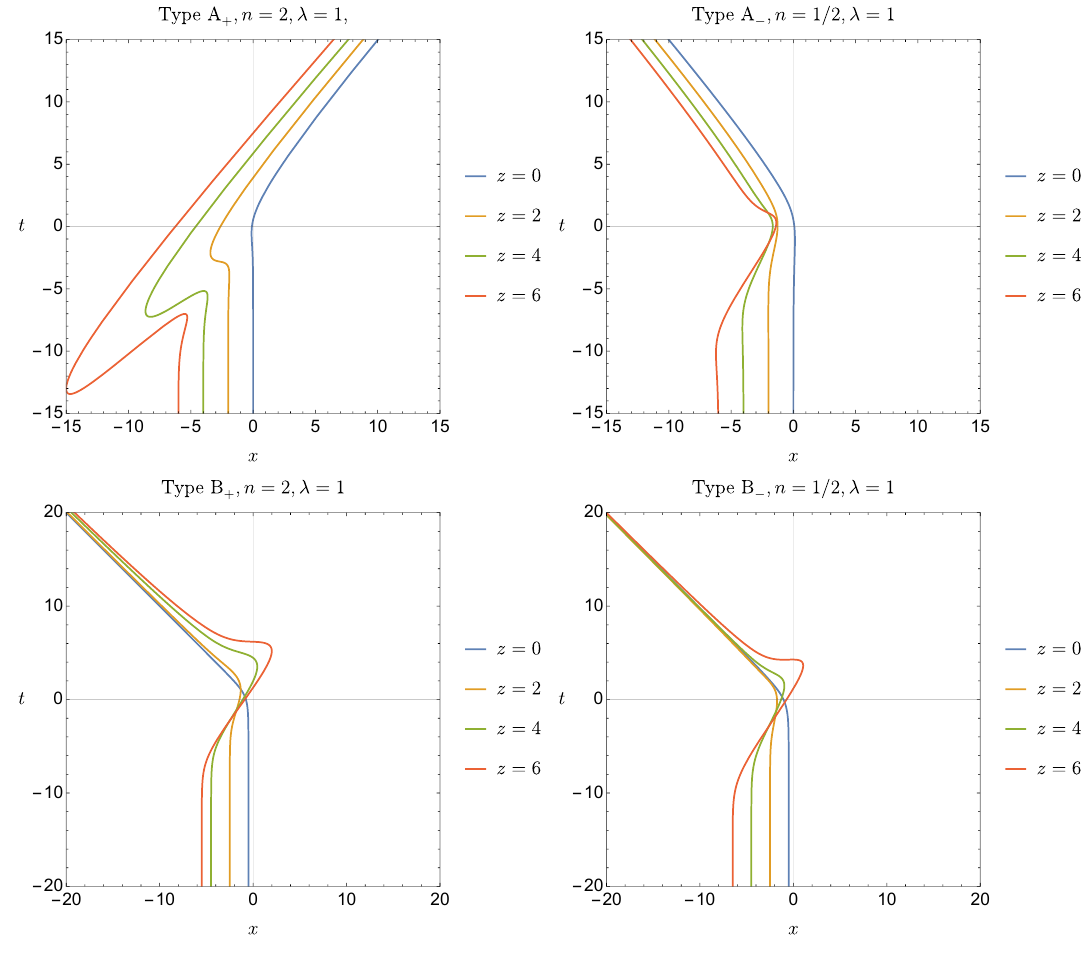
Figure 14 . Profiles of brane Q associated with type A and type B mirrors in terms of ( t, x ) coordinates and for various z . Top: the mapping functions for type A are given in eq. (2.14). Here we have chosen β = 1 and u = 0 as previously. Bottom: the mapping functions for type B are given 0 in eq. (2.18). We have set β = 1 = u 0